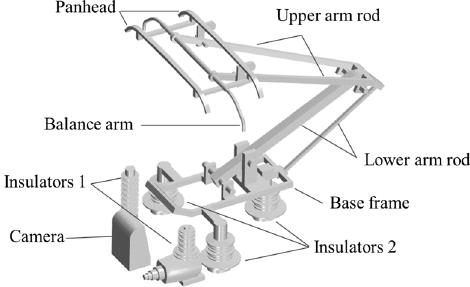
Figure 4. Computational model of pantograph.